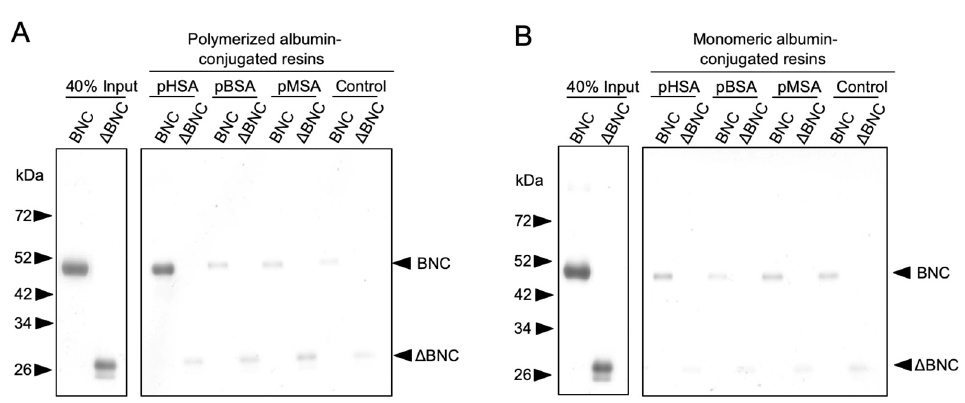
Figure 3. In vitro albumin-binding activity of BNCs. Polymerized ( A ) and monomeric ( B ) forms of human (HSA), bovine (BSA), or mouse (MSA) albumins that were conjugated to resins were incubated with either BNCs or Δ BNCs at 37 °C for 1 h, washed with PBS 4 times, subjected to 12% SDS-PAGE, followed by silver staining. The amounts of precipitated BNCs and Δ BNCs were determined by densitometry. Forty percent input, the loading control. Δ BNCs, PAR-deleted BNCs. Table 2. QCM analysis of interactions between albumins and BNCs.